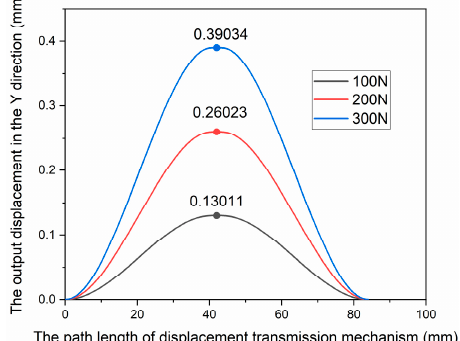
Figure 9. Relationship between force and displacement curve of micro-platform in the Y direction.